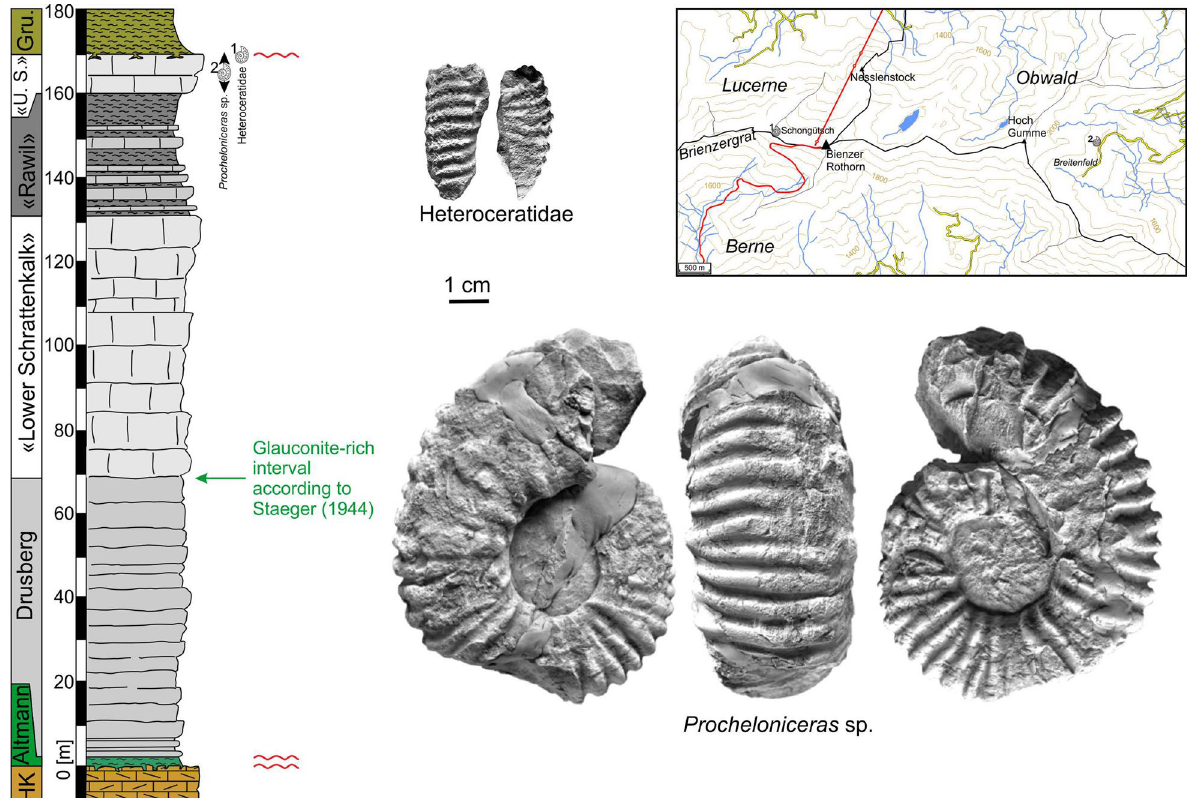
Fig. 18 Stratigraphic log of the Schongütsch section (Brienzergrat, cantons of Lucerne) modified after Jost Stauffer (1993). Heteroceratidae collected by Jost Stauffer (1993) on top of the “Schrattenkalk” Formation, cat. no. 125, Coll. Jost Stauffer, University of Bern. Procheloniceras sp. collected by Staeger (1944) in the “upper Schrattenkalk” Formation at Alp Breitenfeld, Coll. Staeger, University of